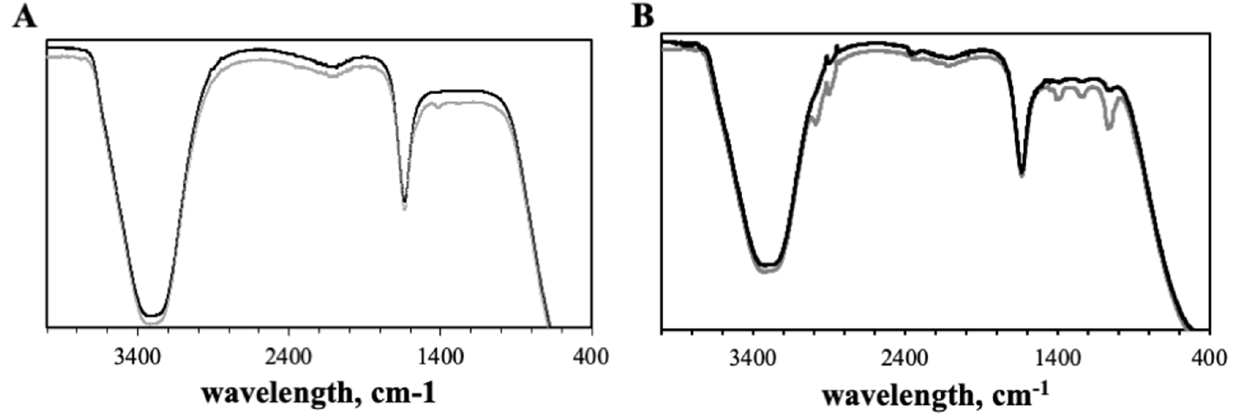
Figure 4. ( A ) FTIR spectra of ChAuNPs (grey line) and EGCG-ChAuNPs (black line). ( B ) FTIR spectra of CystAuNPs (grey line) and EGCG-CystAuNPs (black line). The spectra were shifted for a better visualization.